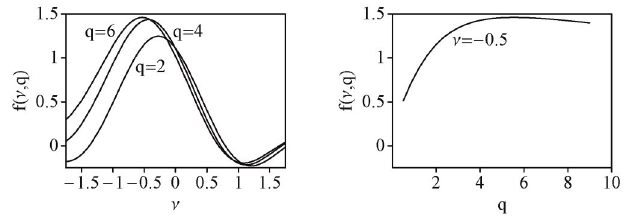
FIG. 3. Function f (cid:3) (cid:22); q (cid:4) .